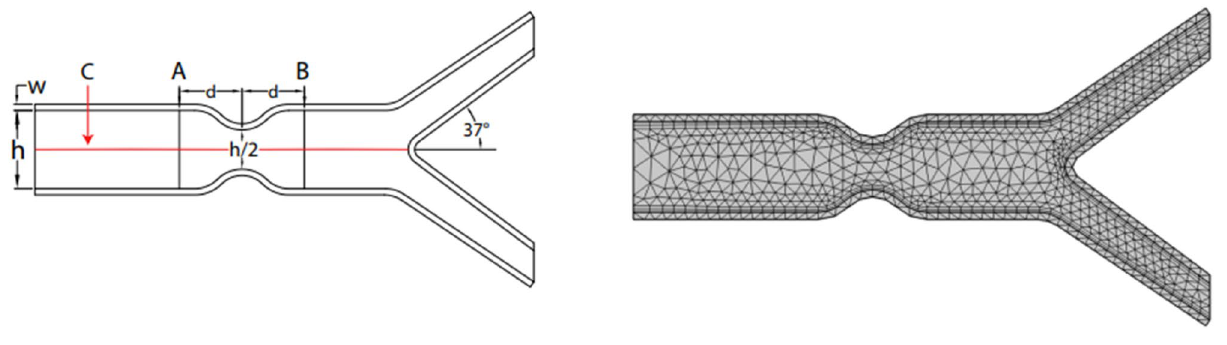
Figure 1. Problem